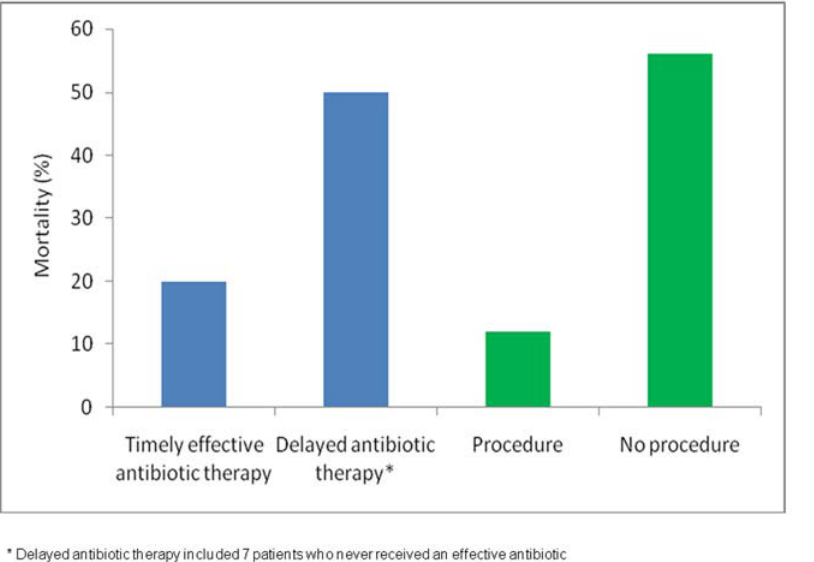
Figure 2. Timely effective antibiotic therapy and procedures for infectious source control significantly improved outcome. Administration of an effective antibiotic on the same day as the positive culture was taken significantly reduced all-cause mortality (p , 0.001), as did undergoing a procedure for infectious source control (p , 0.001).